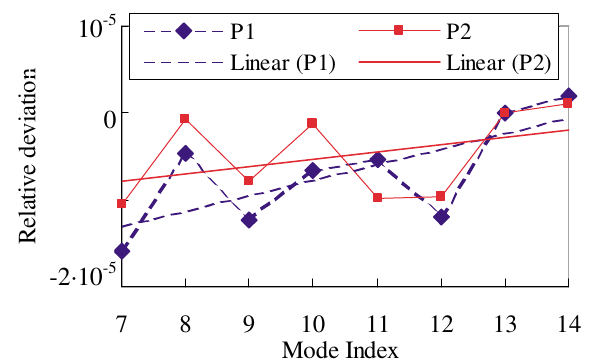
FIG. 4. (Color) Relative deviations (zigzag lines) from ideal linear spectrum shifts (straight lines) as measured for the eight highest modes of both